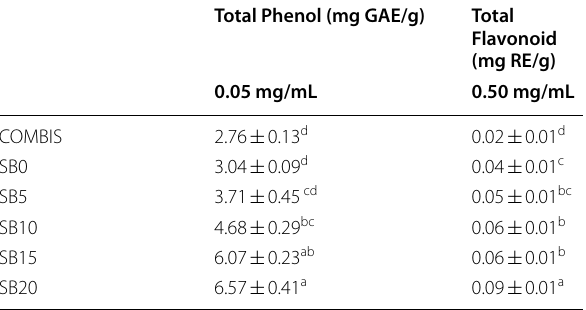
Values are expressed as mean the columns are significantly different at p < 0.05. COMBIS: Commercial